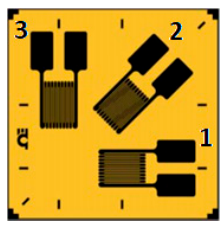
Figure A1. Three directional grid sensors.